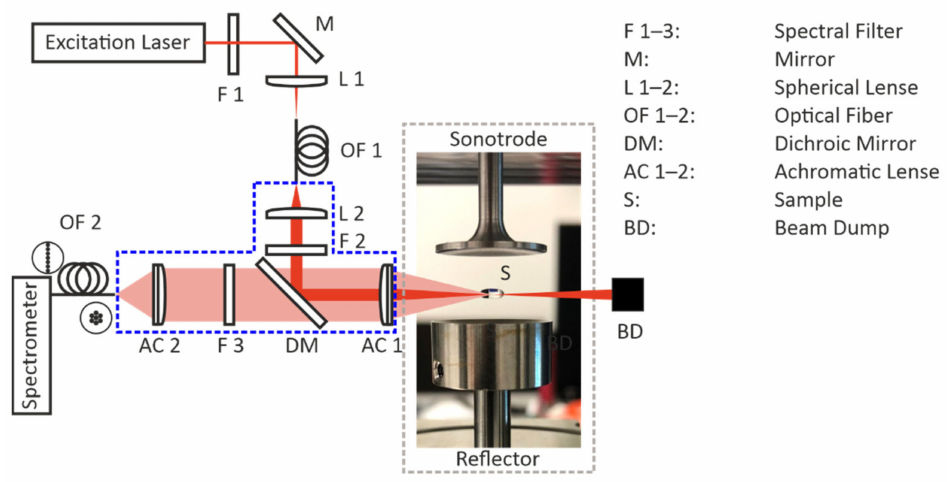
Figure 1. Sketch of the Raman sensor attached to the heating chamber containing the acoustic